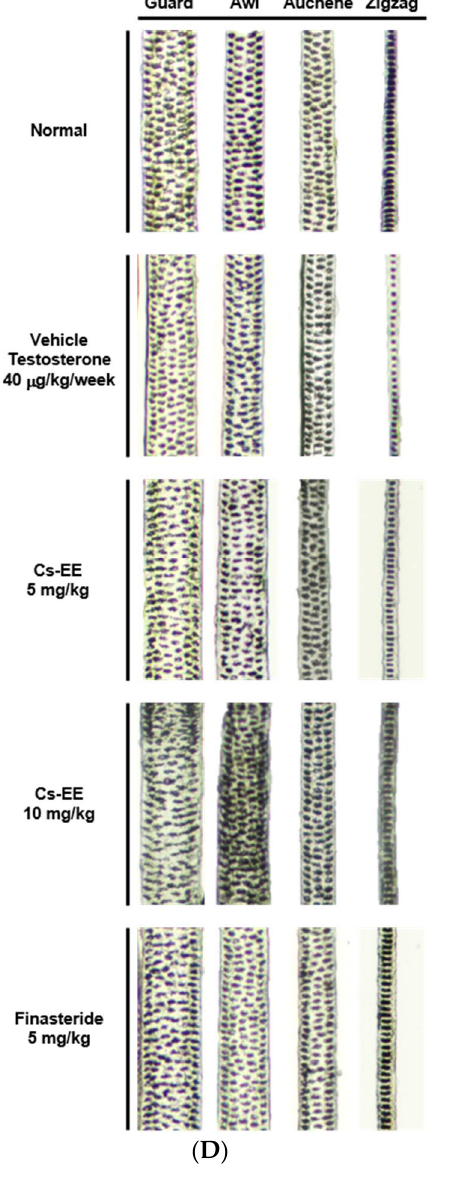
Figure 2. Effects of Cs-EE on the testosterone-induced androgenic alopecia model. ( A ) Morphological observations of mouse backs were collected for three weeks, and ( B ) skin color scores were assigned. ( C ) Hair type frequency (guard, awl, auchene, and zigzag) was measured in each group. ( D ) Photos of each hair type were collected from the five groups for each hair thickness. ( E , F ) The total hair thickness of each group was measured. # : p < 0.05 and ## : p < 0.01 compared with the normal group, * p < 0.05 and ** p < 0.01 compared with the vehicle group (treated with testosterone).